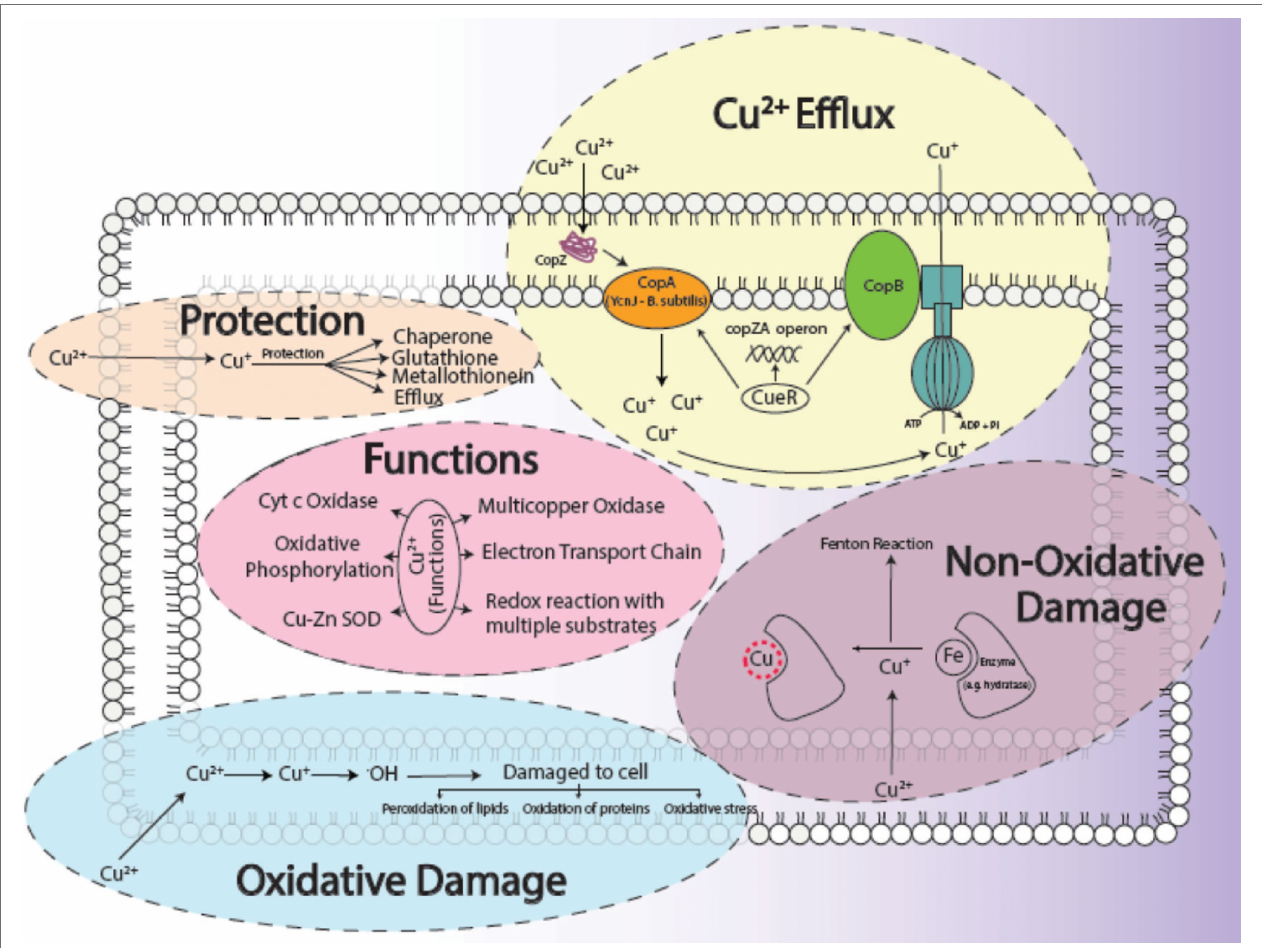
FIGURE 10 | General aspects of copper metabolism in bacterial cells, where it acts as a causative agent for copper-mediated oxidative stress (Ladomersky and Petris, 2015), non-oxidative stress, its efflux (Alotaibi et al., 2021), its major functions (Bondarczuk and Piotrowska-Seget, 2013) in the cell as well as how a cell protects (Giachino and Waldron, 2020) itself from its harmful effects. The conversion of Cu 2+ to Cu + results in the production of ·OH ions, which damages the cells. The replacement of Fe with Cu + initiates the Fenton reaction which ultimately harms the survival of the